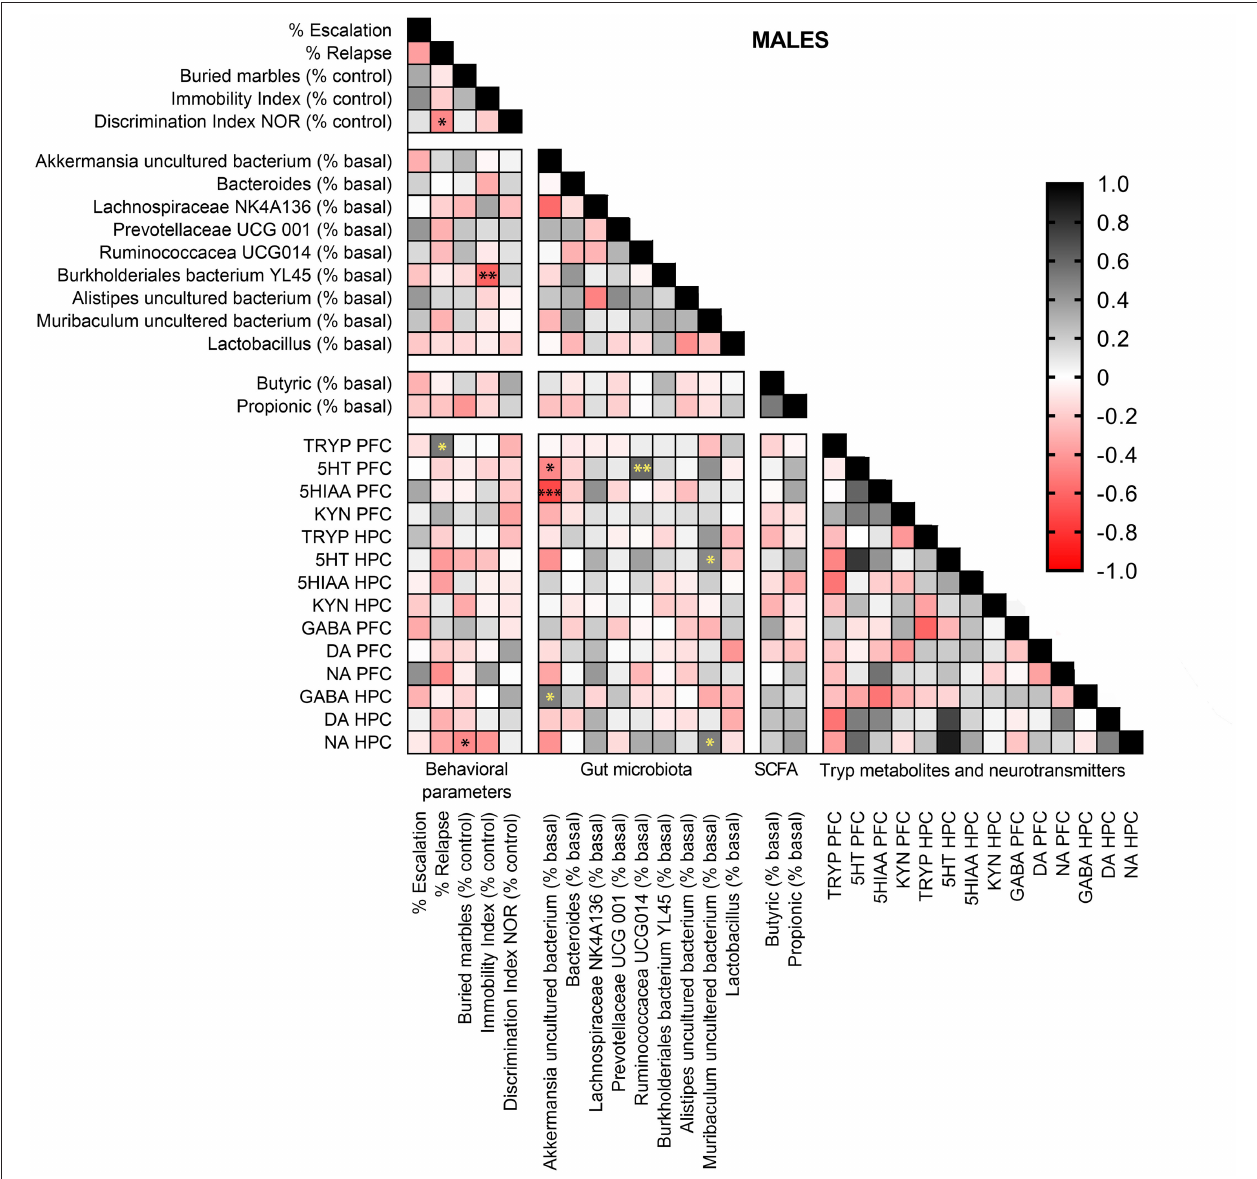
FIGURE 10 | Pearson correlation analysis in male mice exposed to alcohol-water and alcohol-synbiotic comparing behavioral parameters, including escalation (% baseline), relapse (% baseline), depression-like scores (immobility index), anxiety-like scores (buried marbles index), long-term memory (discrimination index in the NOR test) with gut microbial abundance, short-chain fatty acids (SCFA: butyric and propionic acids), tryptophan metabolites: Tryp (tryptophan), serotonin (5-HT), 5-hydroxyindolacetic acid (5-HIAA), kynurenine (KYN), and neurotransmitters including GABA, dopamine (DA) and noradrenaline (NA) concentrations in the prefrontal cortex (PFC) and hippocampus (HPC). Positive correlations are shown in black tones and negative correlations in red tones. Darker tones signify stronger correlations, with significance represented by asterisks (* p < 0.05, ** p < 0.01, *** p <